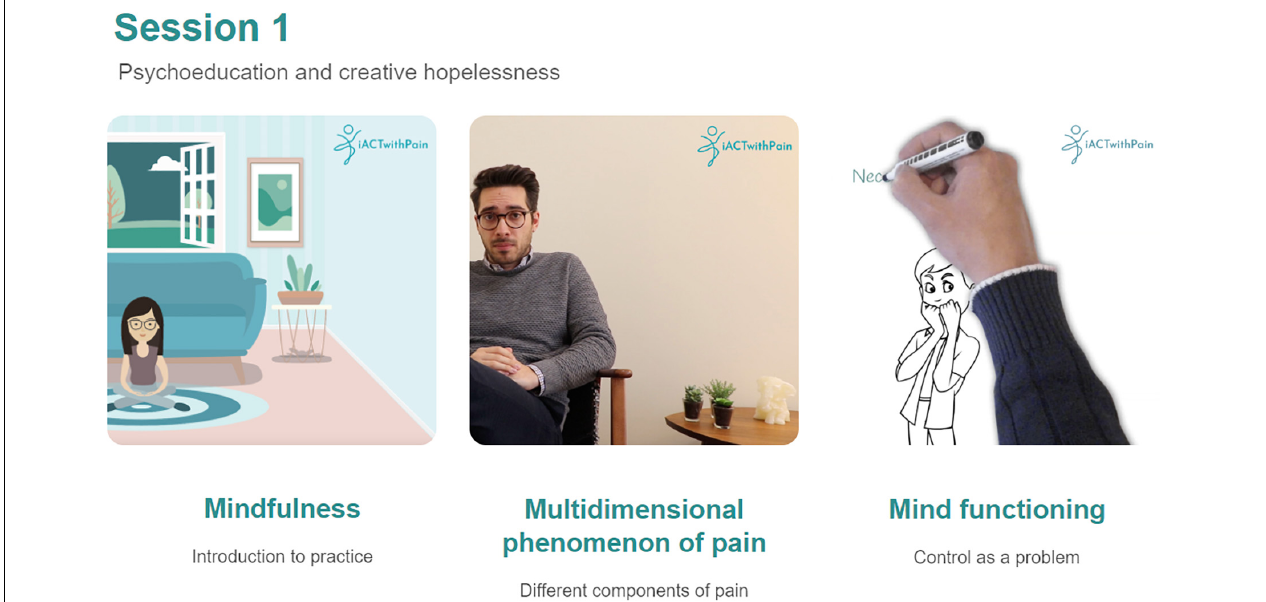
FIGURE 1 | Example of session 1 contents depicting the three types of videos (left to right: video-animation with a therapist avatar, real-image video with a therapist, and videoscribe animated video).